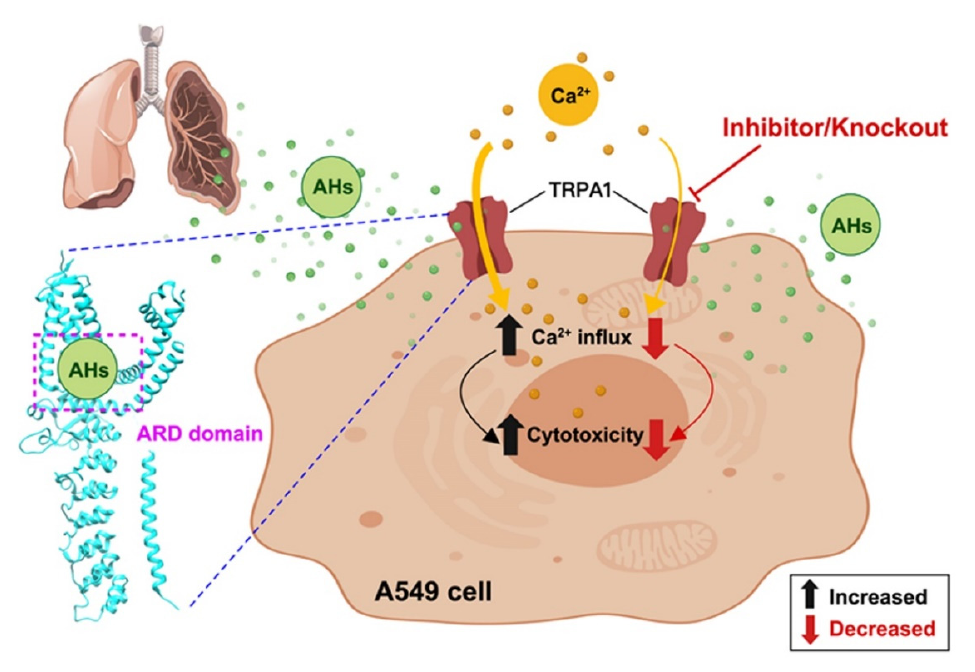
Figure 6. Cytotoxicity mechanism in A549 cells via TRPA1 channel by AHs poisoning.